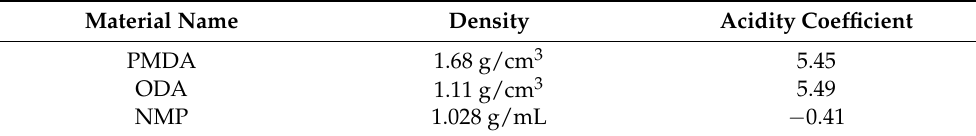
Figure 1. Schematic diagrams of the fabrication process for the CCTO/PI nanocomposite film. Table 1. Main physical and chemical properties of the raw